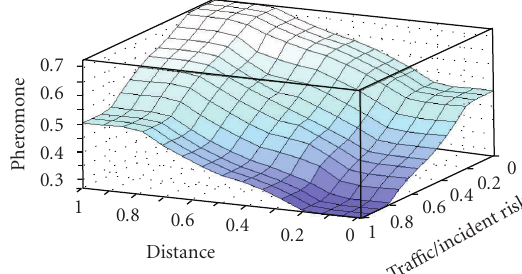
Figure 11: Surface-plot of the proposed FLACS system IF-THEN